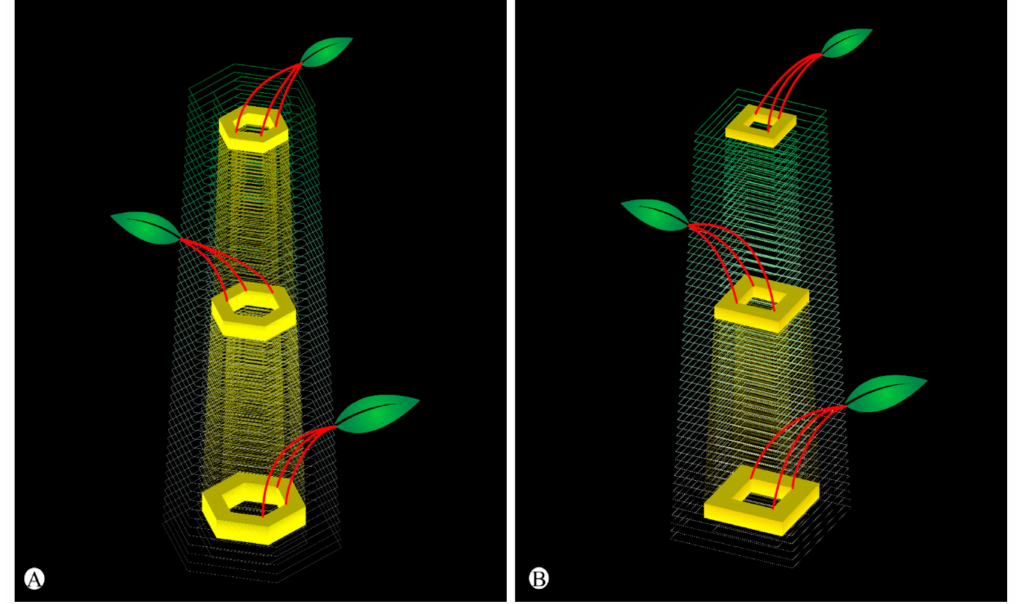
Figure 4. Diagrams showing the leaf traces diverging from stele in Euphorbia attastoma ( A ) and E. tetrangularis ( B ). Note that the leaf traces (red) diverge in groups of three in both